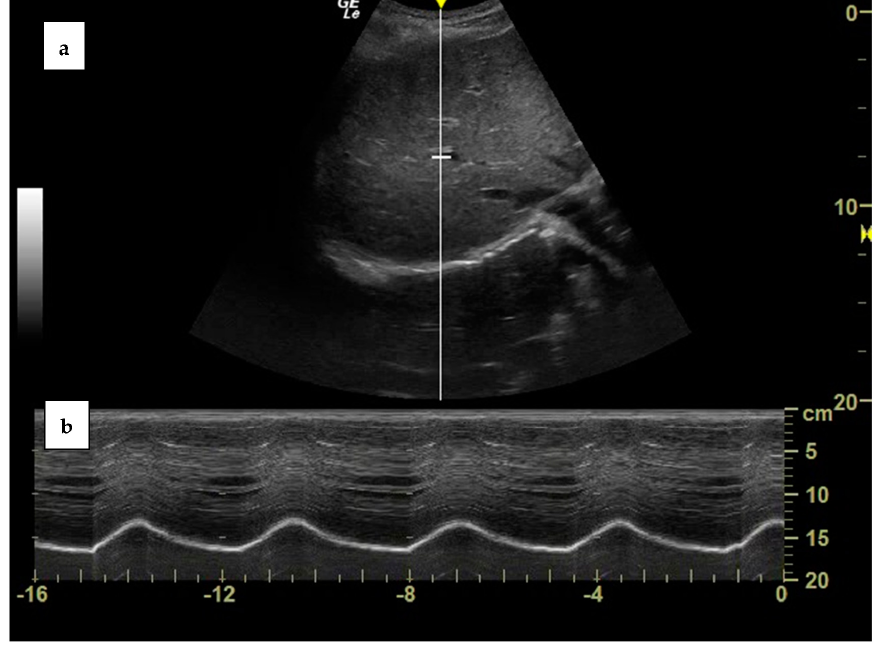
Figure 2. Visualization of the diaphragmatic dome from the right subcostal view in brightness (B) mode ( a ) and of the diaphragmatic excursion in motion (M) mode ( b ) in a healthy subject. Own